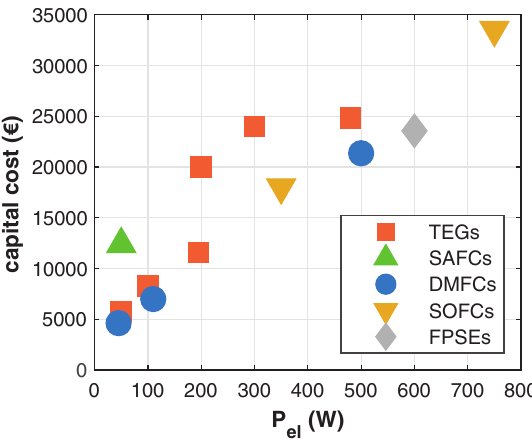
Figure 14. Comparison of capital costs of TEGs, FCs and